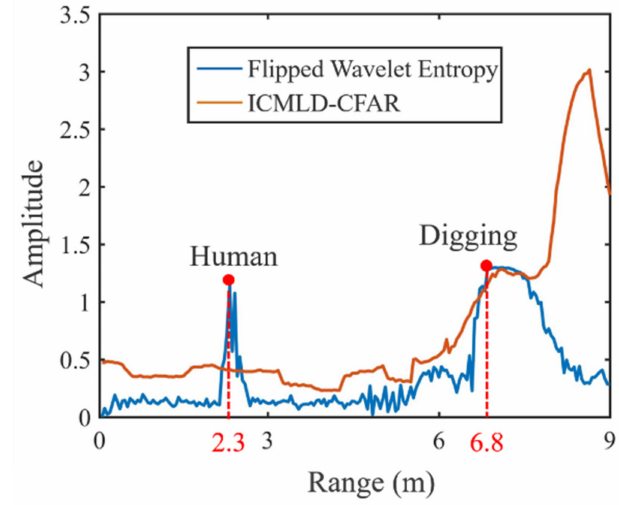
Figure 8. Results of wavelet entropy decomposition and the ICMLD-CFAR.